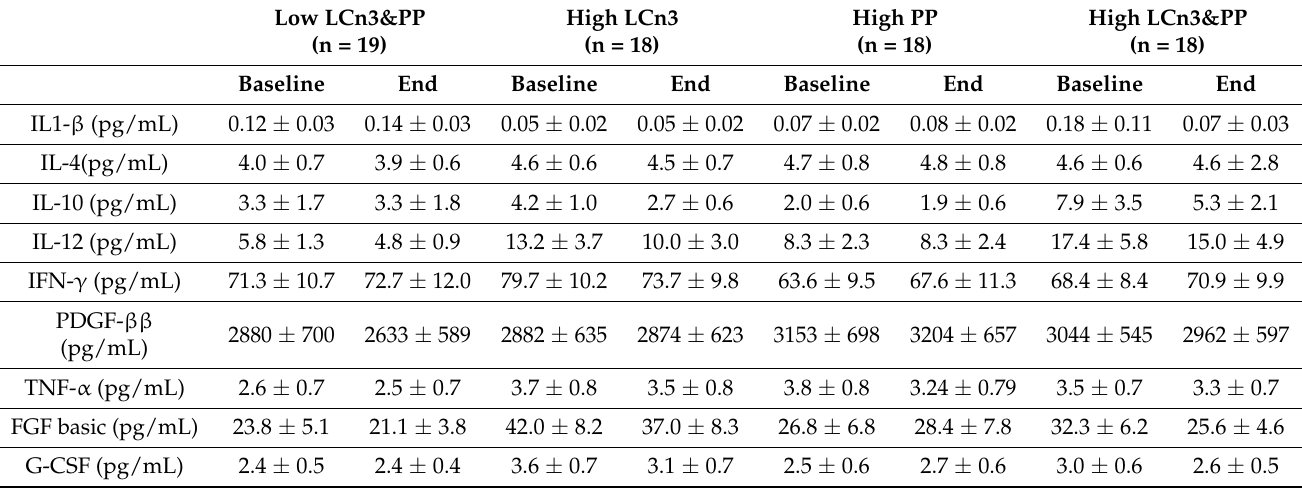
Table 3. Fasting serum concentrations of interleukins and growth factors before (Baseline) and after 8-week